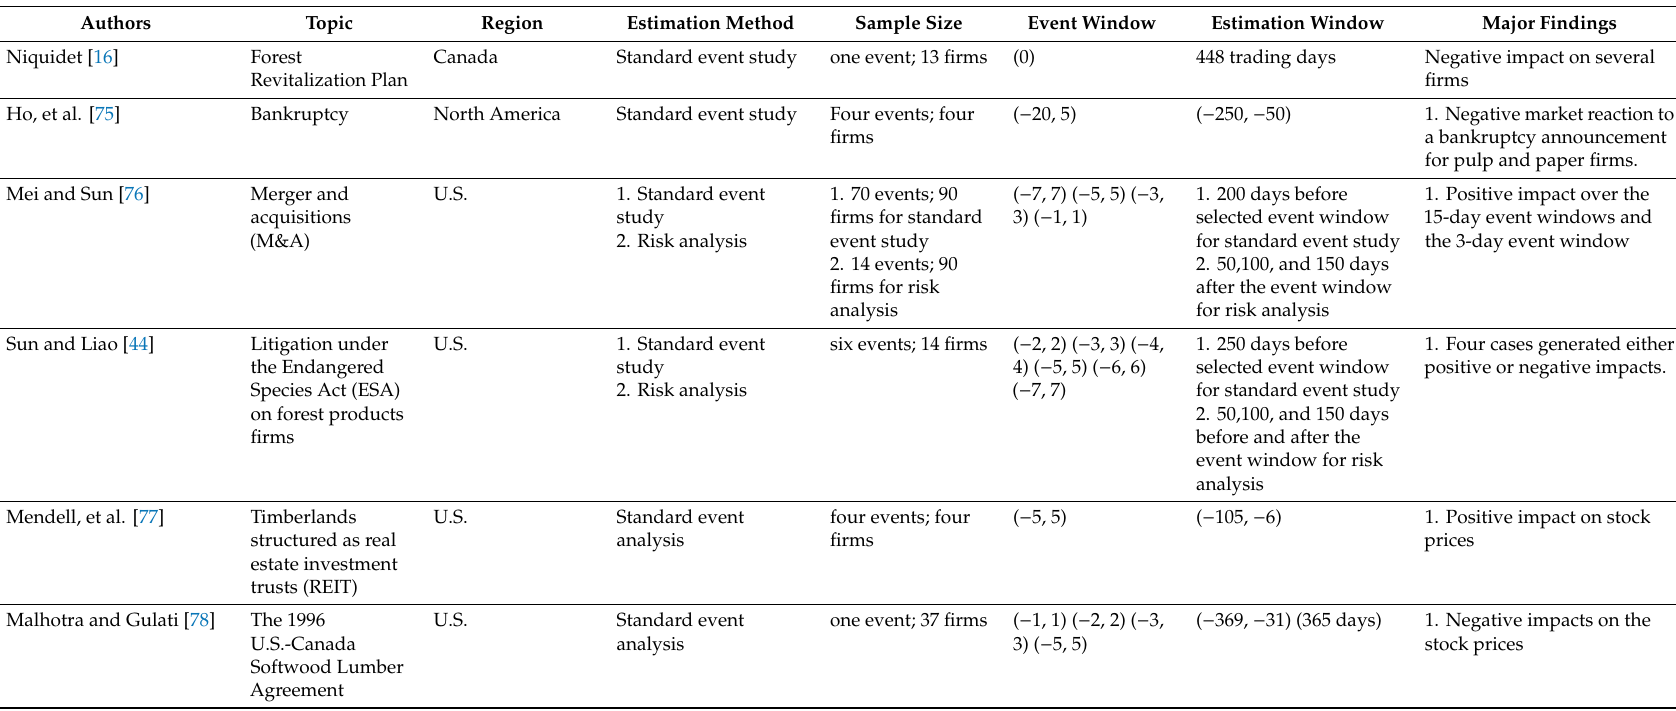
Table A2. Summary of event studies in forest economics and related fields